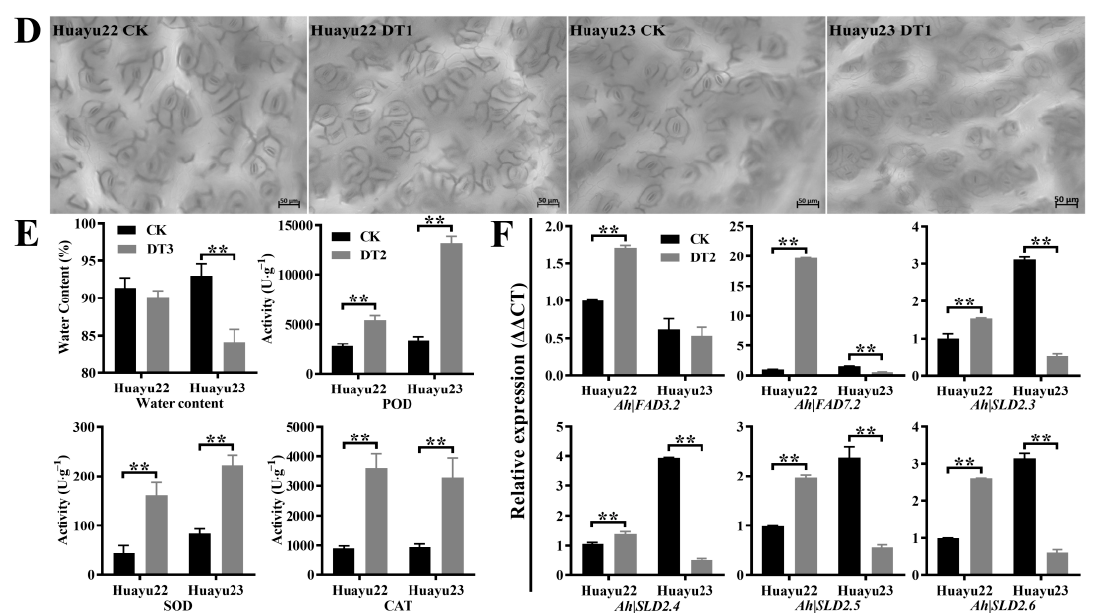
Figure 6. The expression analysis of Arachis hypogaea FAD genes: ( A ) transcriptome expression of Arachis hypogaea FAD genes in 22 tissues. Seeding leaf 10 d post-emergence: leaf 1; main stem leaf: leaf 2; lateral (n + 1) leaf: leaf 3; vegetative shoot tip from main stem: veg shoot; reproductive shoot tip from first lateral (n + 1): repr shoot; 10 d roots: root; 25 d nodules: nodule; perianth, gynoecium: pistil; androecium: stamen; aerial gynophore tip: peg tip 1; subterranean gynophore tip (24 h): peg tip 2; Pattee 1 pod: fruit Pat. 1; Pattee 1 stalk: peg tip Pat. 1; Pattee 3 pod: fruit Pat. 3; Pattee 5 pericarp: pericarp Pat. 5; Pattee 5 seed: seed Pat. 5; Pattee 6 pericarp: pericarp Pat. 6; Pattee 6 seed: seed Pat. 6; Pattee 7 seed: seed Pat. 7; Pattee 8 seed: seed Pat. 8; Pattee 10 seed: seed Pat. 10; ( B ) transcriptome expression of FAD genes in drought-sensitive (FH18) and -tolerant (NH5) species under drought